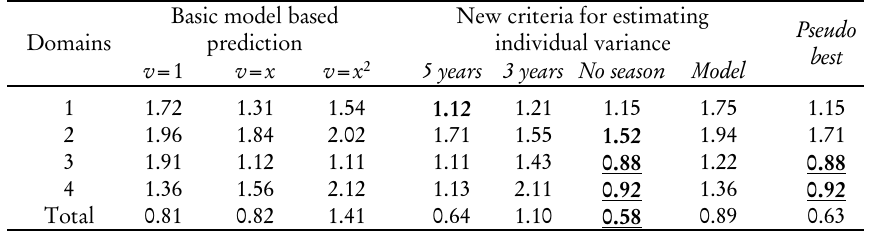
Comparison among MAPEs obtained through the use of the optimal model based predictor and different criteria for model unit variance estimation Mean of 4 quarters – Real data referred to 2010 – Estimates with post-stratification New criteria for estimating Domains